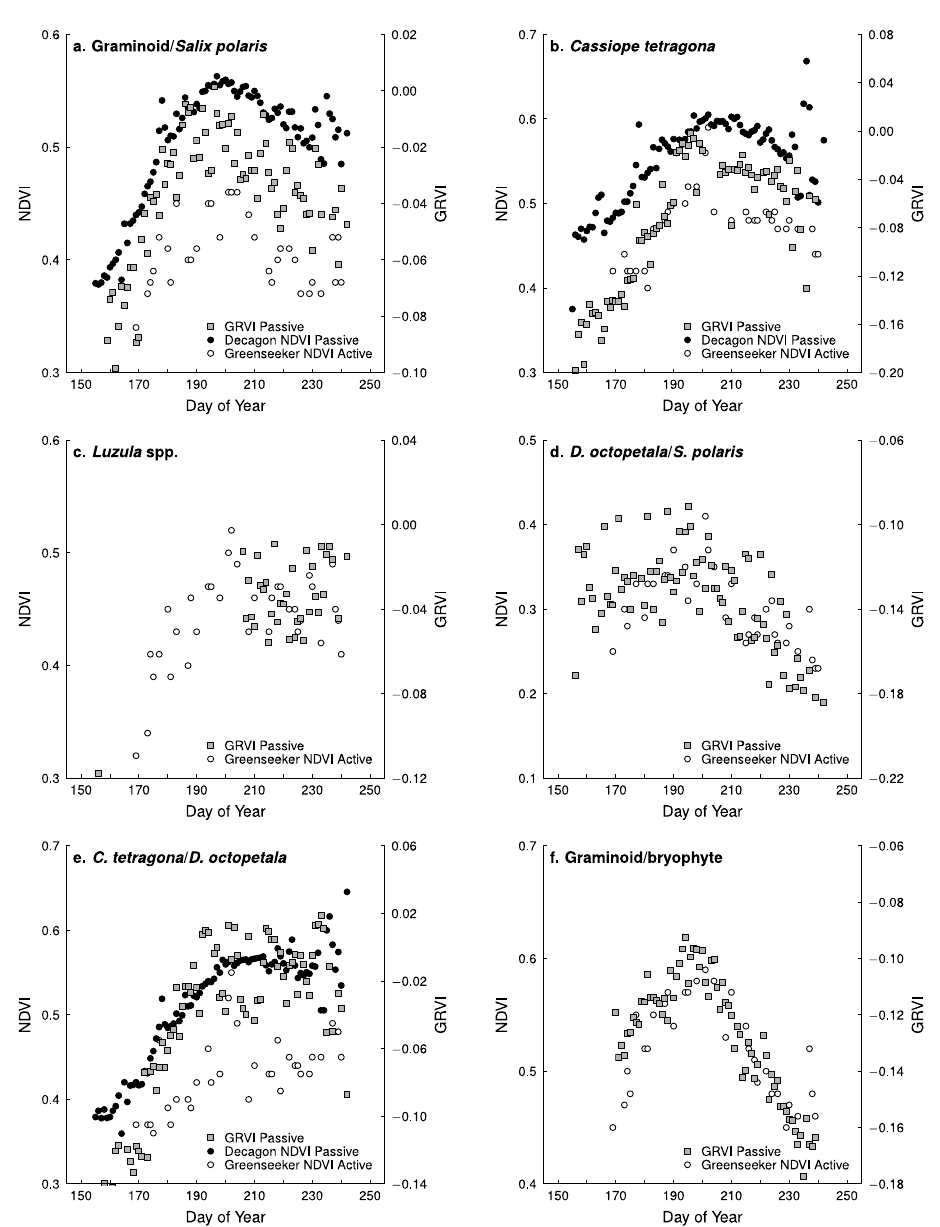
Figure 2. NDVI and greenness index values from six different High Arctic plant communities throughout the growing season. Readings were taken between 5 June (day of year = 156) and 30 August (day of year = 242) 2015 in ( a ) Graminoid/ Salix polaris ; ( b ) Cassiope tetragona ; ( c ) Luzula spp.; ( d ) Dryas octopetala / Salix polaris ; ( e ) Cassiope tetragona / Dryas octopetala ; and ( f ) Graminoid/bryophyte vegetation. NDVI was recorded using Decagon surface reflectance sensors (black circles) and a Trimble Greenseeker handheld sensor (open circles); the Green-Red Vegetation Index (GRVI) values (grey squares) were calculated from red and green channel data from RGB images.